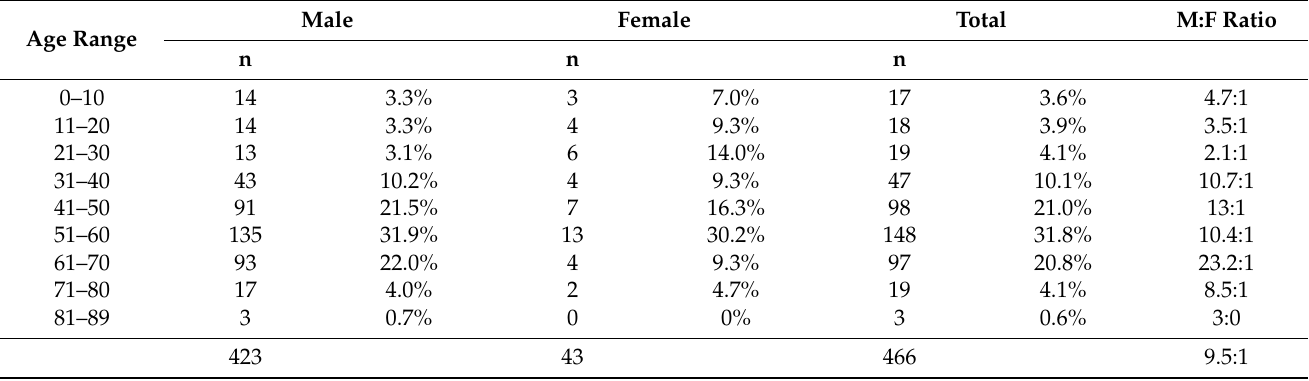
Figure 2. Geographical distribution of PCM cases assigned by provincial departments. Provinces: (1) Jujuy and (2) Salta are included in the northwest endemic region (NWA). Provinces: (3) Formosa, (4) Chaco, (5) Misiones, (6) Santiago del Estero, (7) Corrientes, (8) Santa Fe, and (9) Entre Ríos integrate the northeast endemic zone (NEA). Sex distribution strati fi ed by age ranges of all patients including male: female (M:F) ratio is shown in Table 1. Table 1. Sex/age distribution of 466 PCM patients recorded in Argentina.